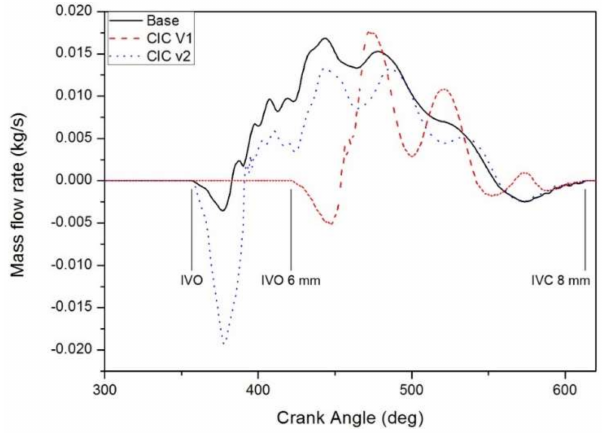
Figure 5. Flow traces at intake valve for different recompression strategies.